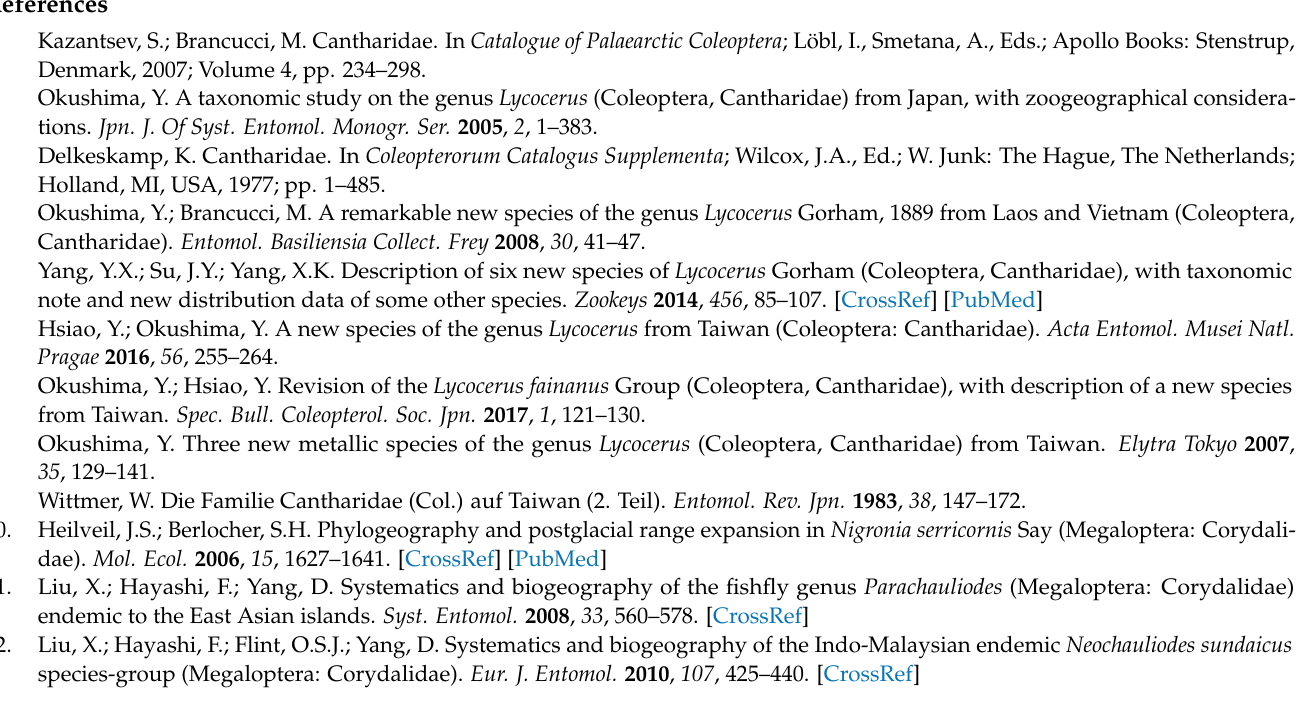
Table S2: The matrix of character states of Lycocerus fainanus species-group in phylogenetic analysis; Table S3: The distribution information for all species of Lycocerus fainanus